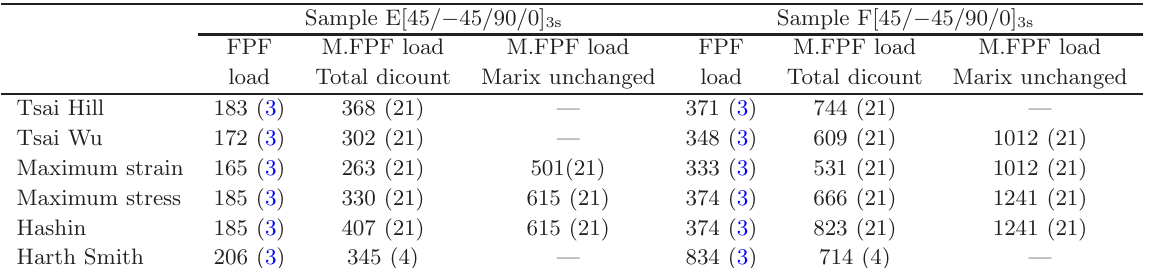
Table 7. Failure loads for samples E and F.